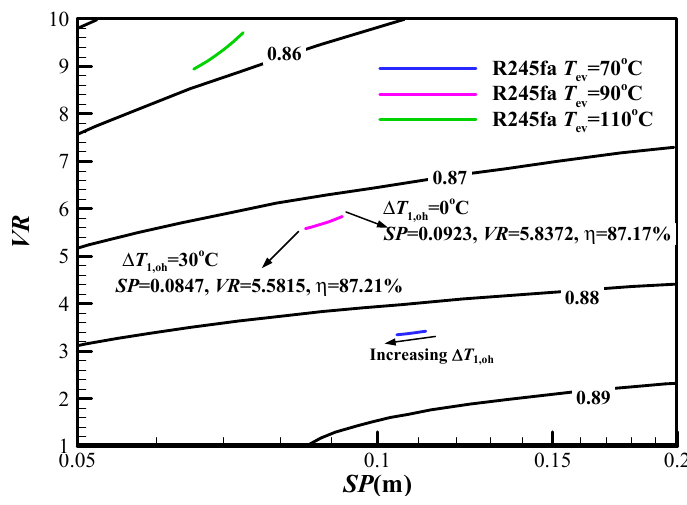
Figure 4. Variation of turbine efficiency versus overheating degree.